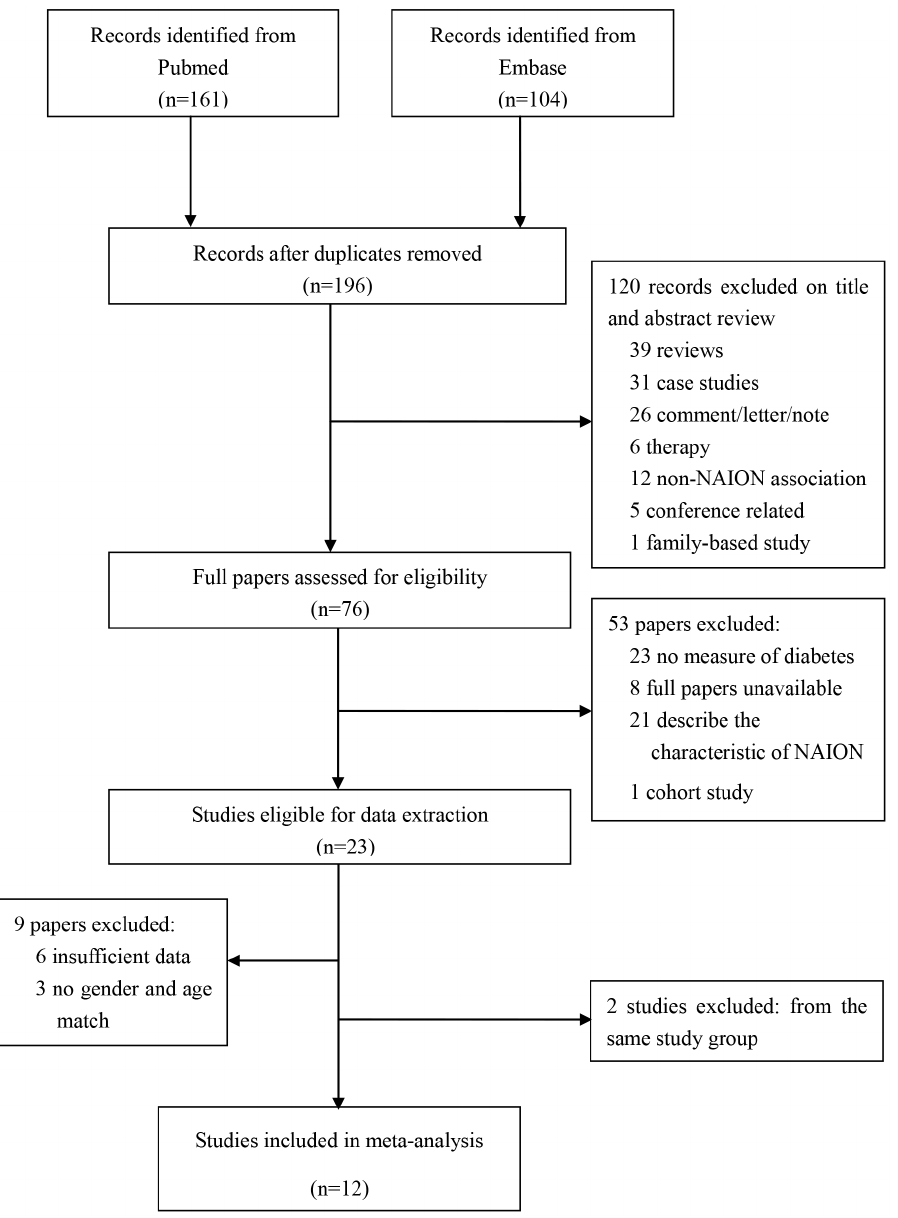
Figure 1. Flow diagram outlining the selection process for studies in the systematic review and meta-analysis.